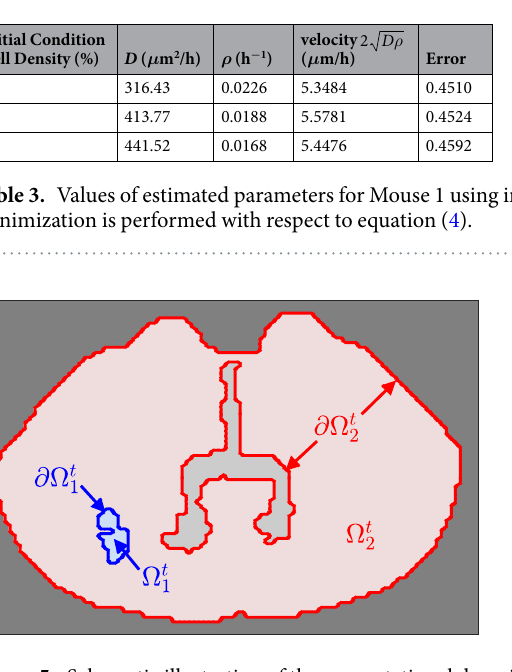
Figure 5. Schematic illustration of the computational domain of the moving boundary initial value problem for tumor growth. The blue area ( Ω t ) represents the tumor cells, the light gray area represents the ventricles, the red 1 area ( Ω t ) represents the remainder of the brain, and the dark gray represents the area outside of the 2